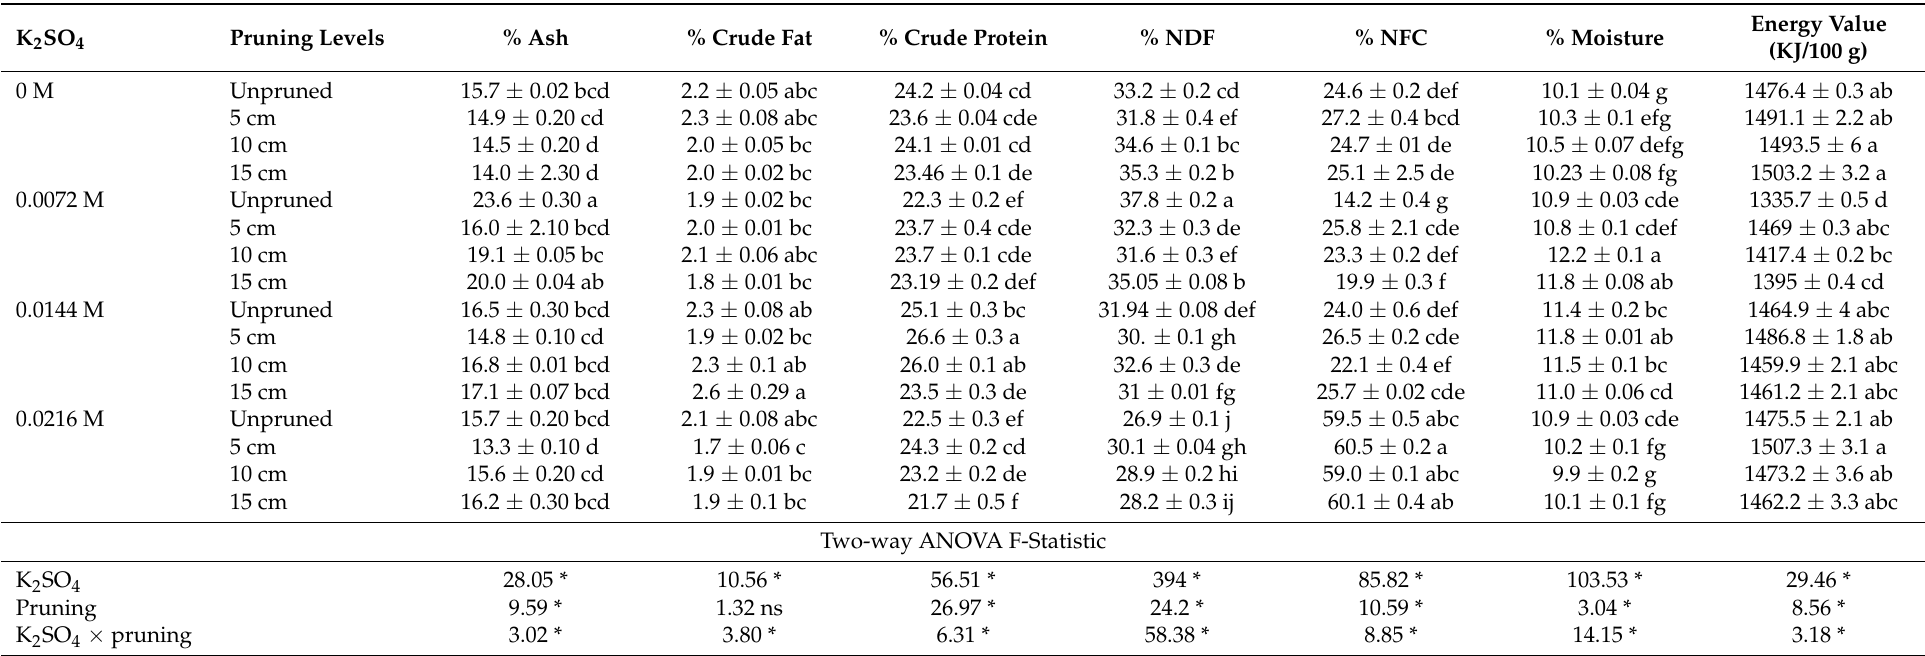
Table 4. The effect of potassium and pruning levels on proximate composition of flower buds of hydroponically grown T. divaricata